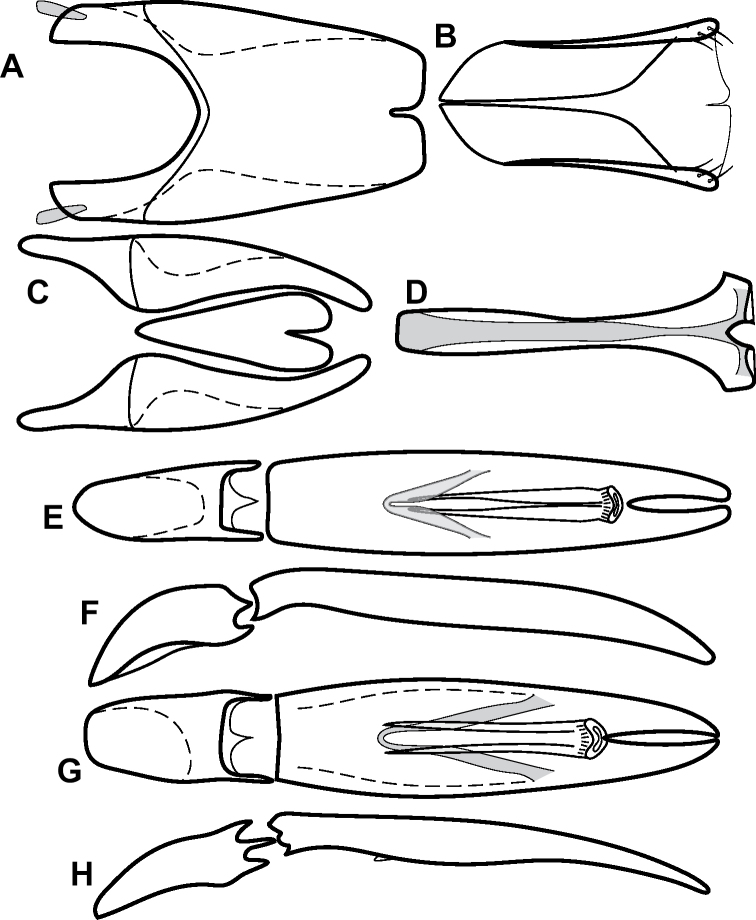
Male genitalia A–DPhelister
trigonisternus Hinton: A tergite 8 B sternite 8 C tergites 9 & 10 D sternite 9 E, FPhelister
blairi Lewis: E aedeagus, dorsal F aedeagus, lateral G, HP.
erwini: G aedeagus, dorsal H aedeagus, lateral.